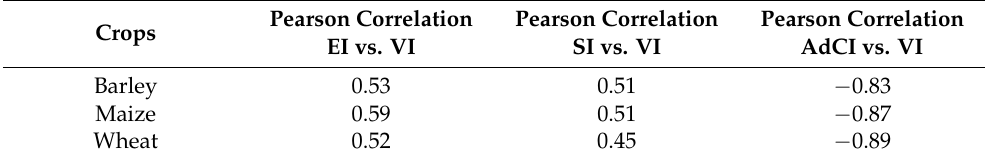
Table 2. Pearson Correlations between the Sensitivity (SI), Exposure (EI), Adaptive Capacity (AdCI) Indexes vs the Vulnerability Index (VI) at the Sub-national